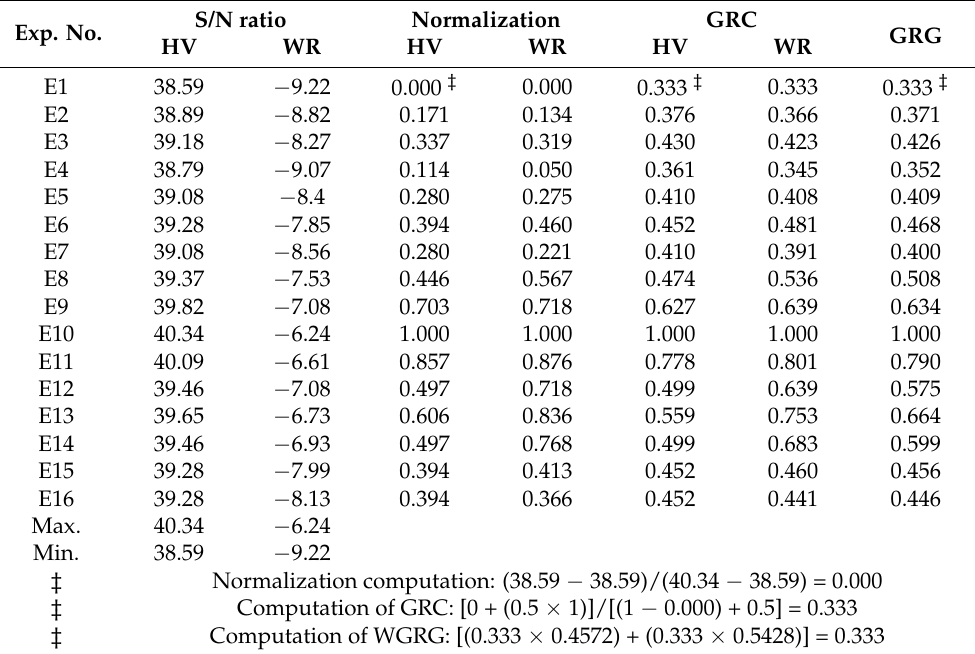
Table 9. Results of multiobjective optimization—GRA. S/N ratio Exp. No.